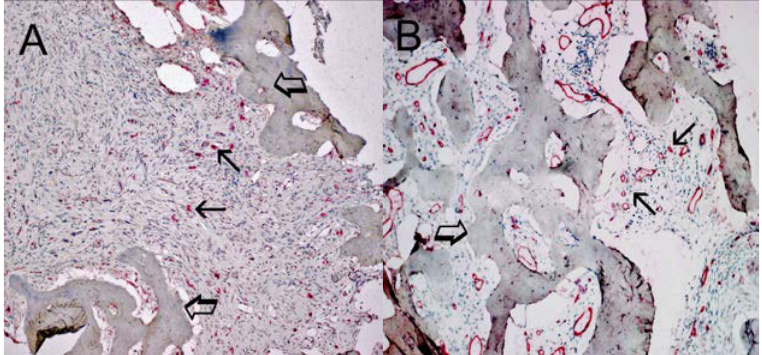
Figure 4. ( A ) Bone metastasis from gastric cancer tissue section. Many scattered mast cells positive to tryptase are seen as immunostained red. Small arrows indicate single mast cells. Large arrows indicate bone tissue. Low magnification: 100×; ( B ) Bone metastasis from gastric cancer tissue section. Many red immunostained microvessels are present. Small arrows indicate clusters of microvessels; note the small lumen. Large arrows indicate bone tissue. Low magnification: